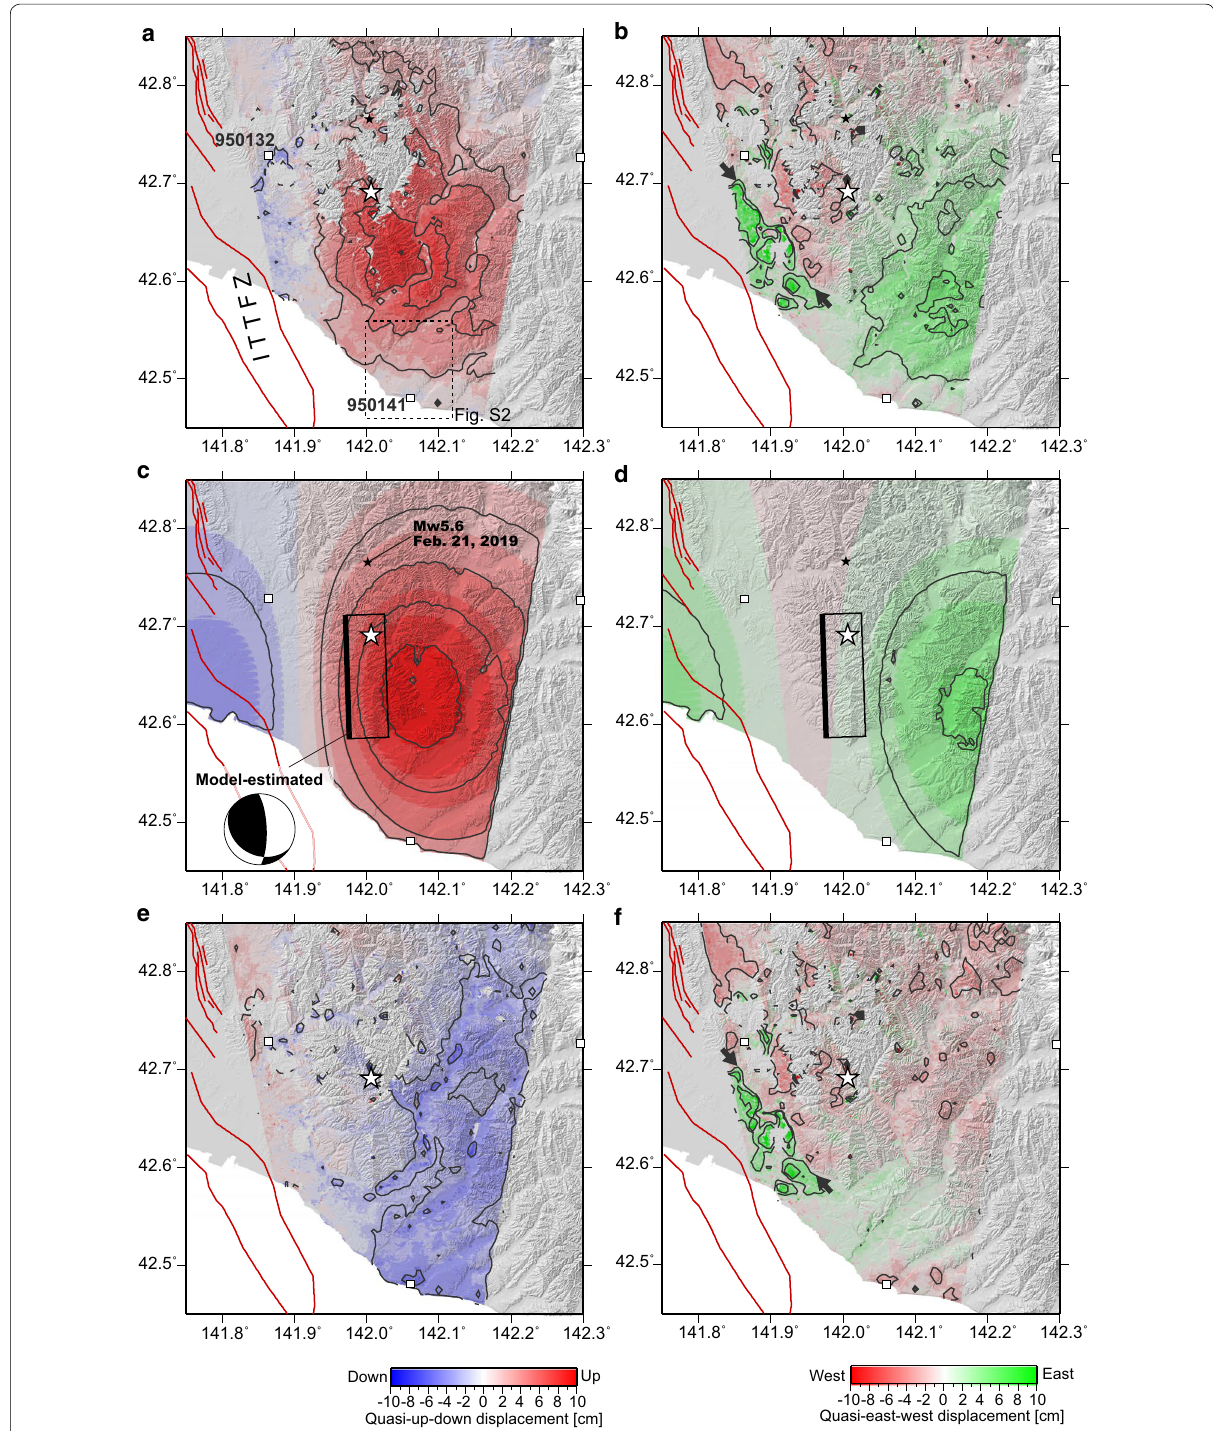
Fig. 2 a InSAR-derived displacements in a quasi-up-down component. The red and blue colors indicate uplift and subsidence, respectively. b A quasi-east–west component. The green and red colors indicate eastward and westward movements, respectively. c Model-predicted displacement for a quasi-up-down component. Black frame represents an estimated fault plane, projected on the ground. The beach ball diagram calculated from the estimated fault parameters is shown at the bottom-left. d Same as ( c ) but for a quasi-east–west component. e Residuals for a quasi-up-down component. f Same as ( e ) but for a quasi-east–west